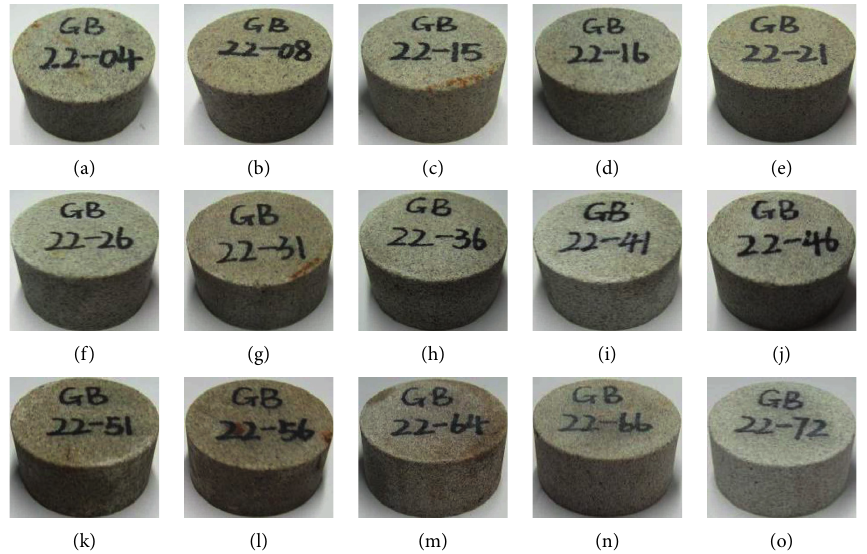
Figure 3: Apparent morphology of sandstone specimens after water bath at different temperatures. (a) 25 ° C. (b) 30 ° C. (c) 35 ° C. (d) 40 ° C.